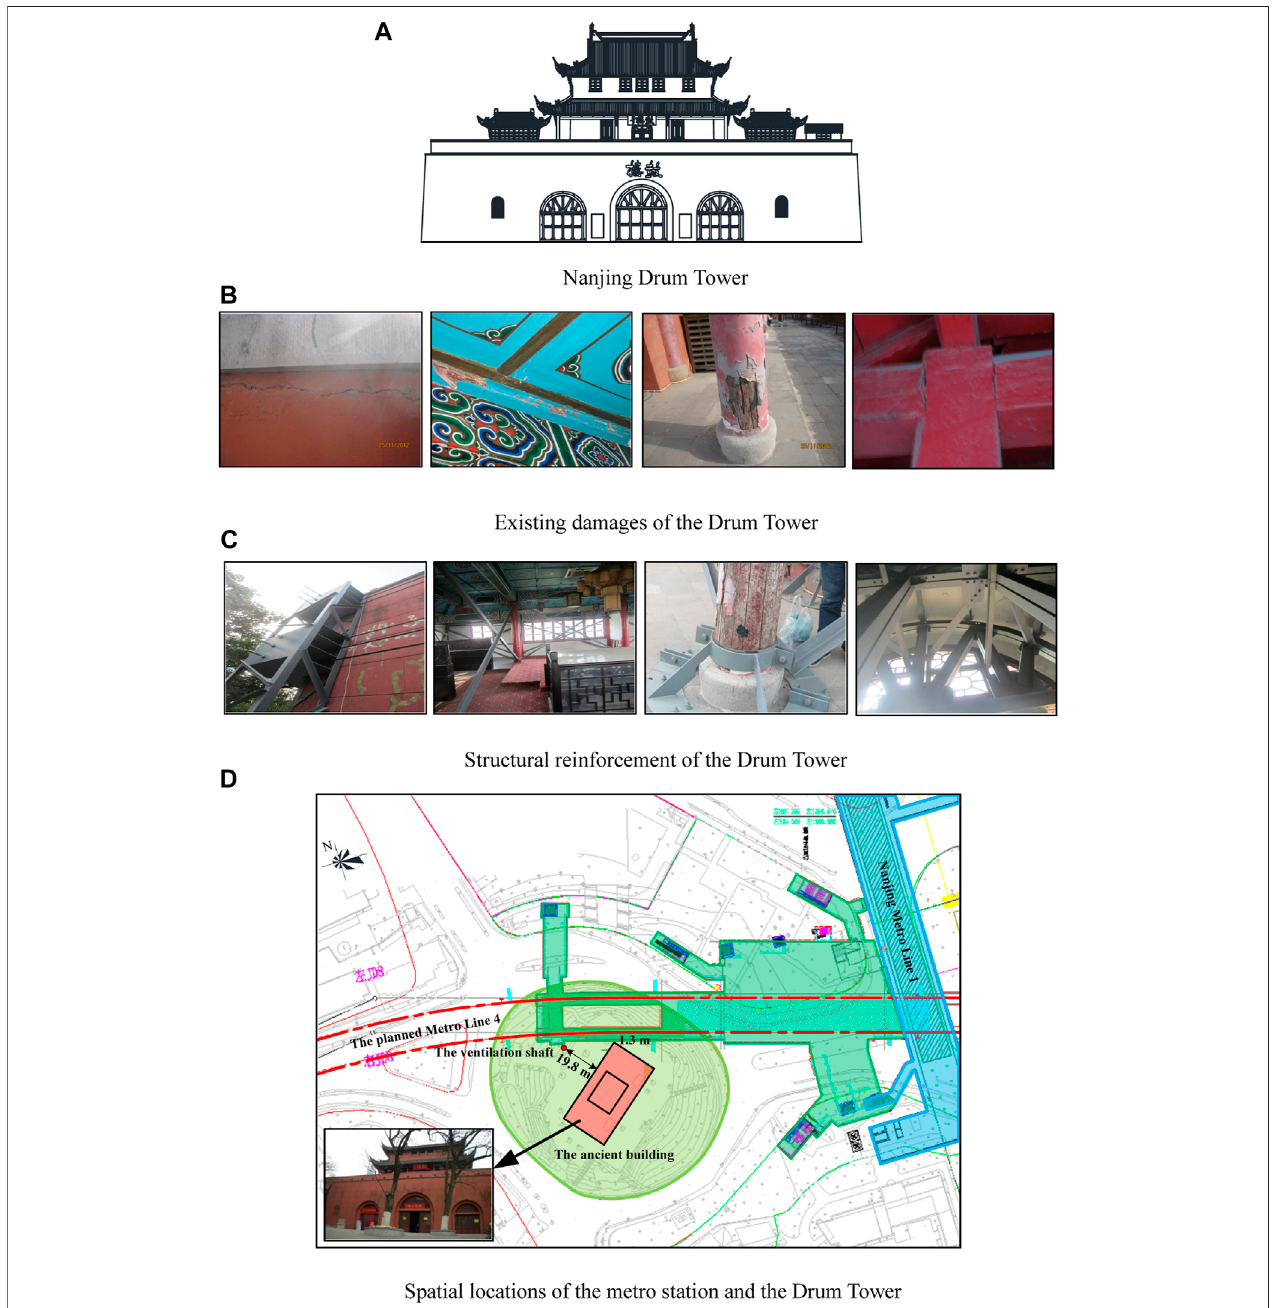
FIGURE 1 | Overview of Nanjing Drum Tower. (A) Nanjing Drum Tower, (B) existing damages of the Drum Tower, (C) structural reinforcement of the Drum Tower, (D) spatial locations of the metro station and the Drum Tower.